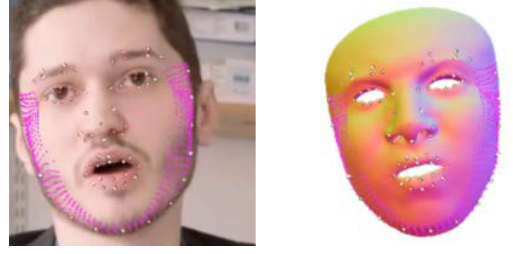
Fig. 2 Example of detected coarse landmarks and reconstructed facial mesh for a single